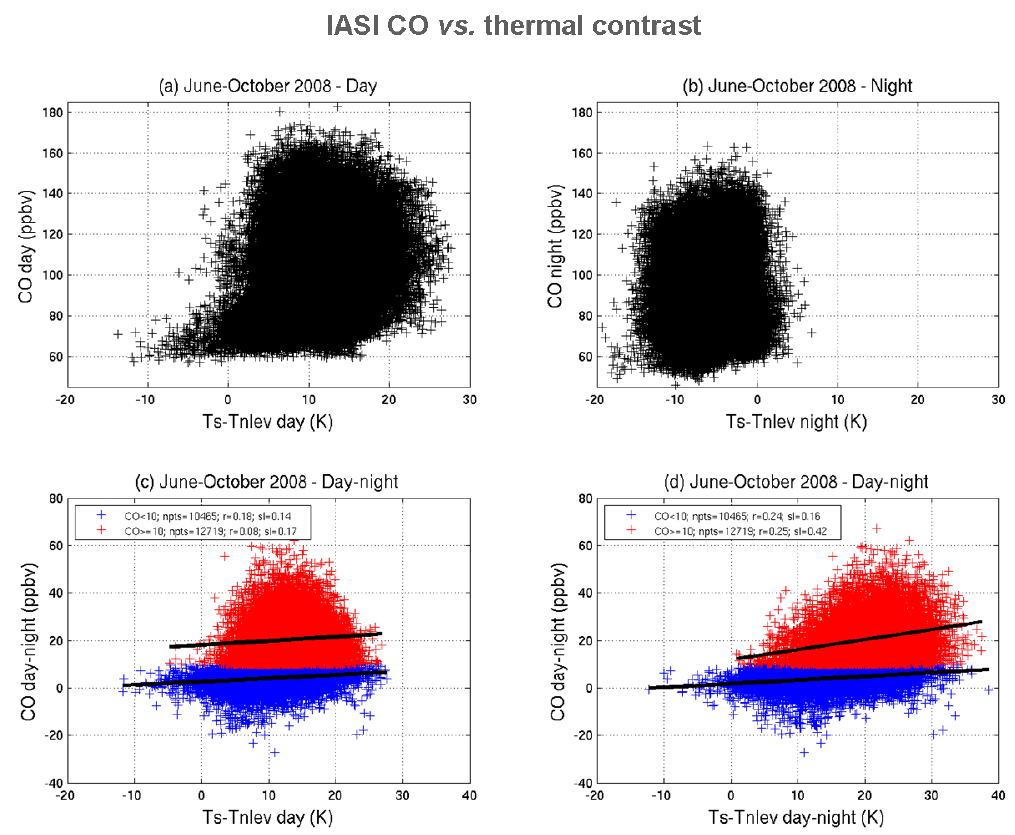
Figure 10. (a) IASI CO (inppbv) by day as a function of the thermal contrast (in K), between June and October 2008, in southern Africa, on land. (b) Same as (a) , by night. (c) Day–night difference of IASI CO (inppbv) as a function of the thermal contrast by day (in K). (d) Same as (c) for the day–night difference of the thermal